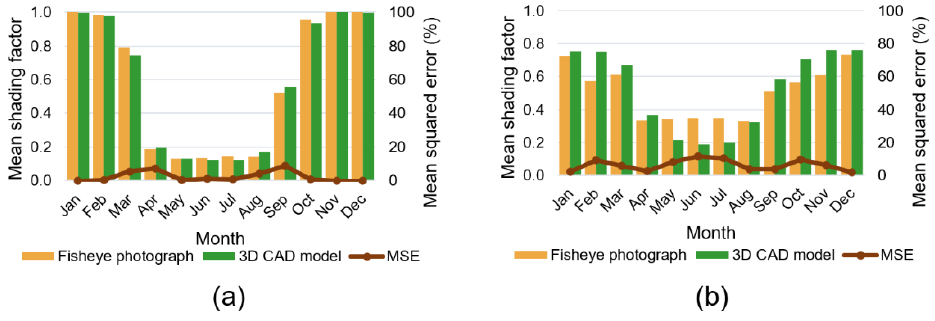
Figure 18. Mean shading factors based on 3D models with buildings and trees or fisheye images at survey points ( a ) B1 and ( b ) B4. Table 6. Mean shading factors over one year during May–October and November–April, estimated using a 3D model with and without tree models at survey points B1 and